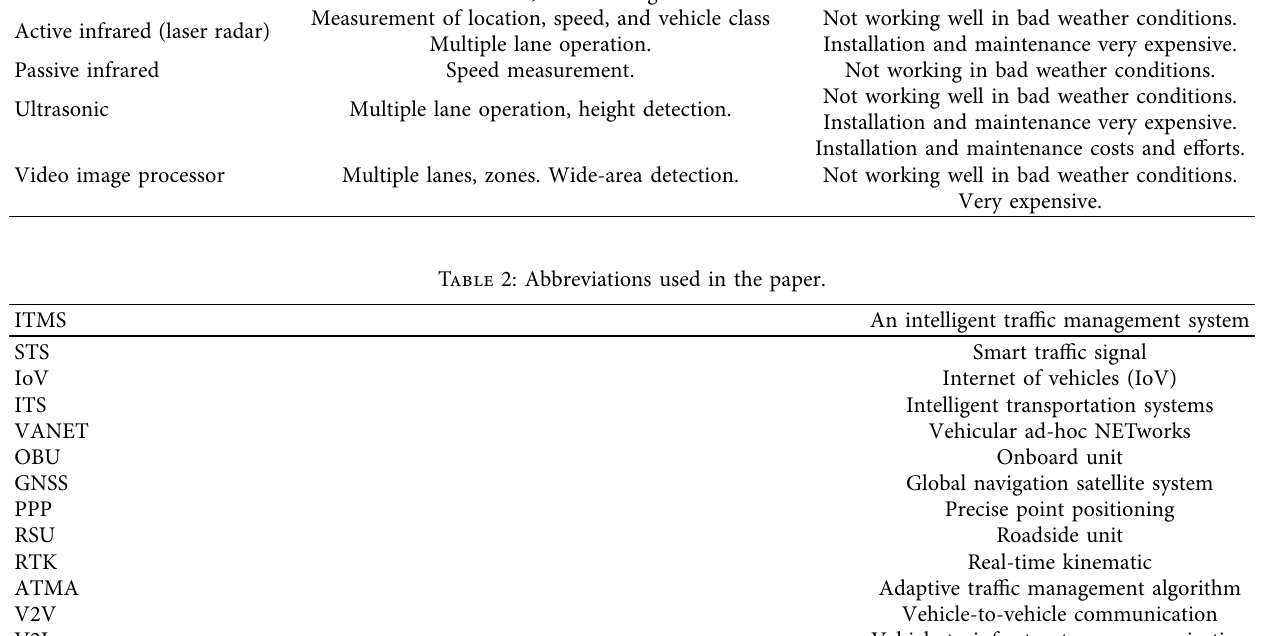
Table 3: Notations—parameter and symbol definitions that are used in the algorithms and the figures. Symbol